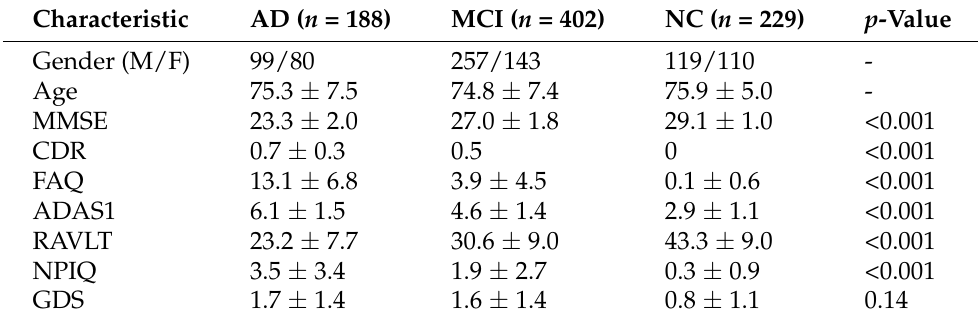
Table 1. Subject